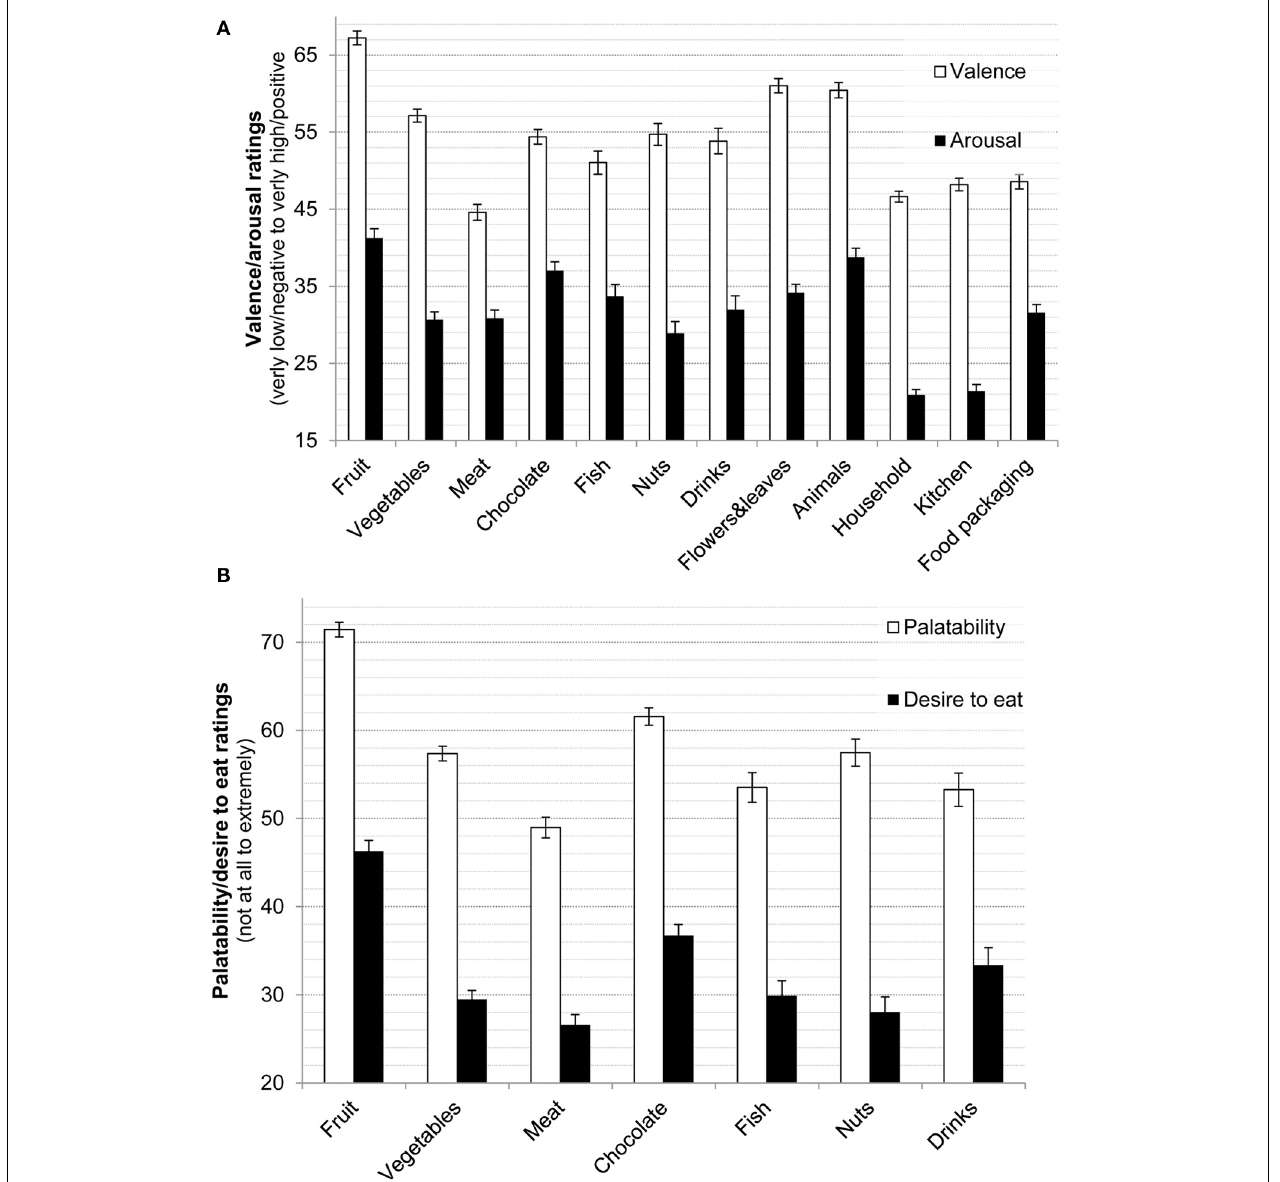
FIGURE 2 | (A) Means and 95% confidence intervals for valence (“very negative” to “very positive”) and arousal (“very little” to “very high”) across all image categories. (B) Means and 95% confidence intervals for palatability and desire to eat (both “not at all” to “extremely”) across food types.